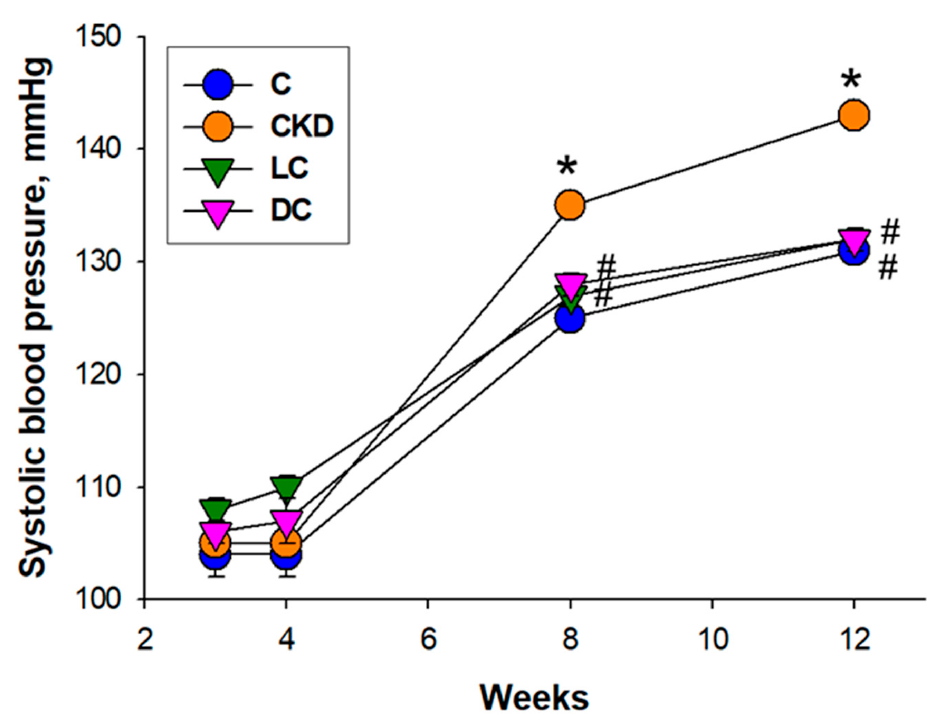
Figure 1. Effect of maternal chronic kidney disease (CKD), L -cysteine (LC), and D -cysteine (DC) on systolic blood pressures in male rat progeny from 3 to 12 weeks of age. n = 8/group; * p < 0.05 vs. C; # p < 0.05 vs. CKD.